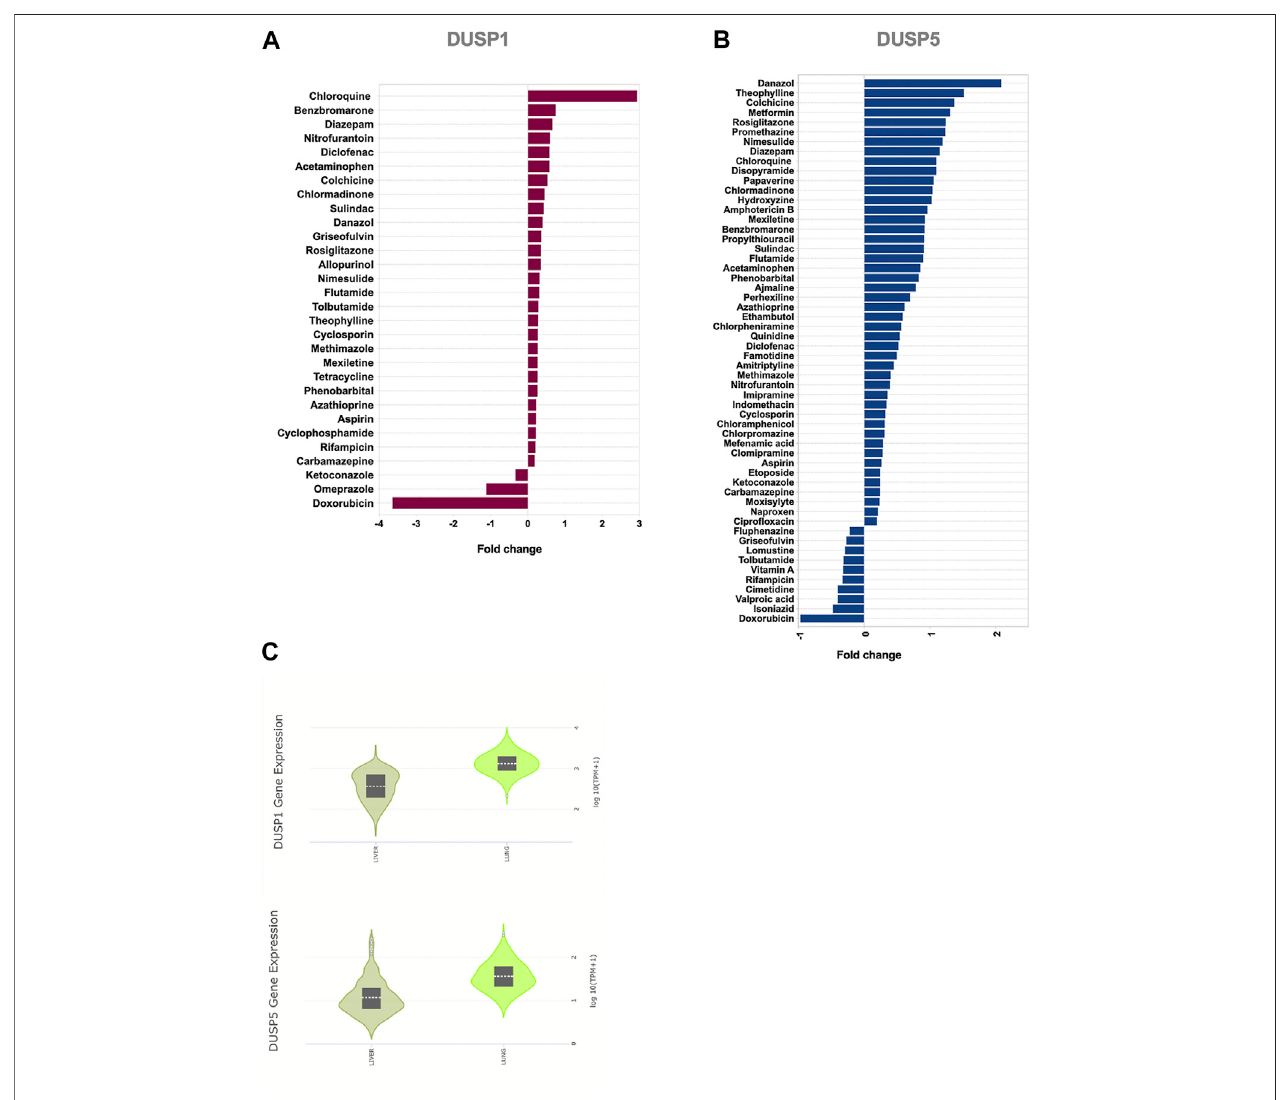
FIGURE 5 | Effect of common medications on the expression levels of DUSP1 and DUSP5 in human primary hepatocytes (A,B) Medications with a signi fi cant regulatoryeffect onthegeneexpression levelsof DUSP1 (A) and DUSP5 (B) .Statistical test: Limmaadjusted p < 0.05 (C) Baseline expression of DUSP1 and DUSP5 in healthy liver and lung tissue extracted from the Genotype-Tissue Expression (GTEx) project. The data shows that the gene expression levels of DUSP1 and DUSP5 in healthy liver tissues, on which the medication has been tested, is comparable with their lung expression